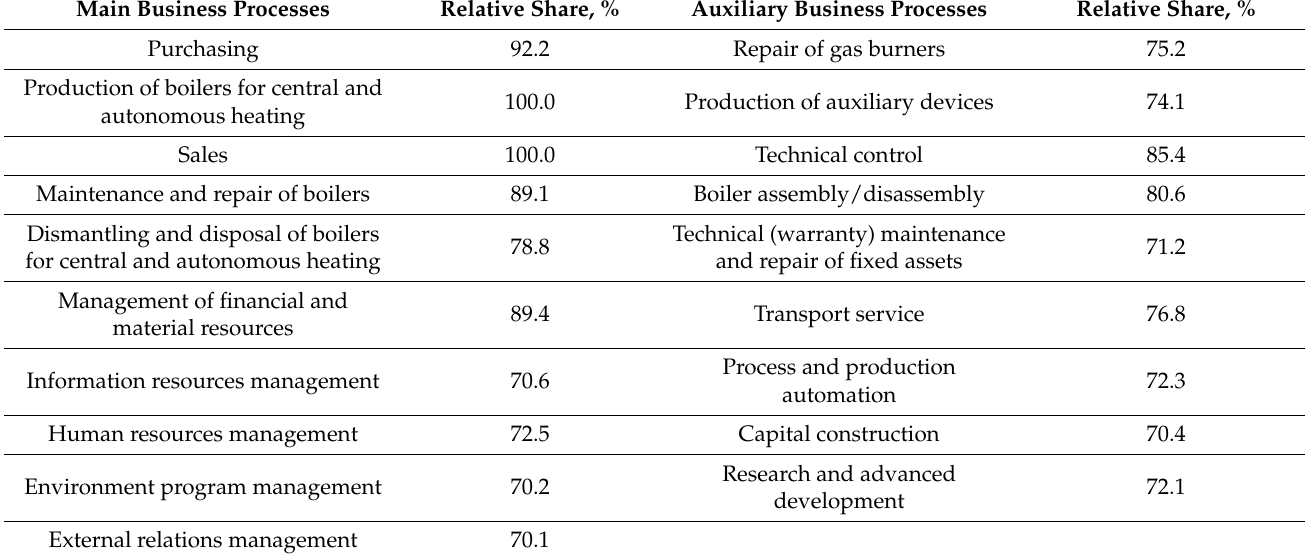
Table 1. Structure of business processes in boiler manufacturing